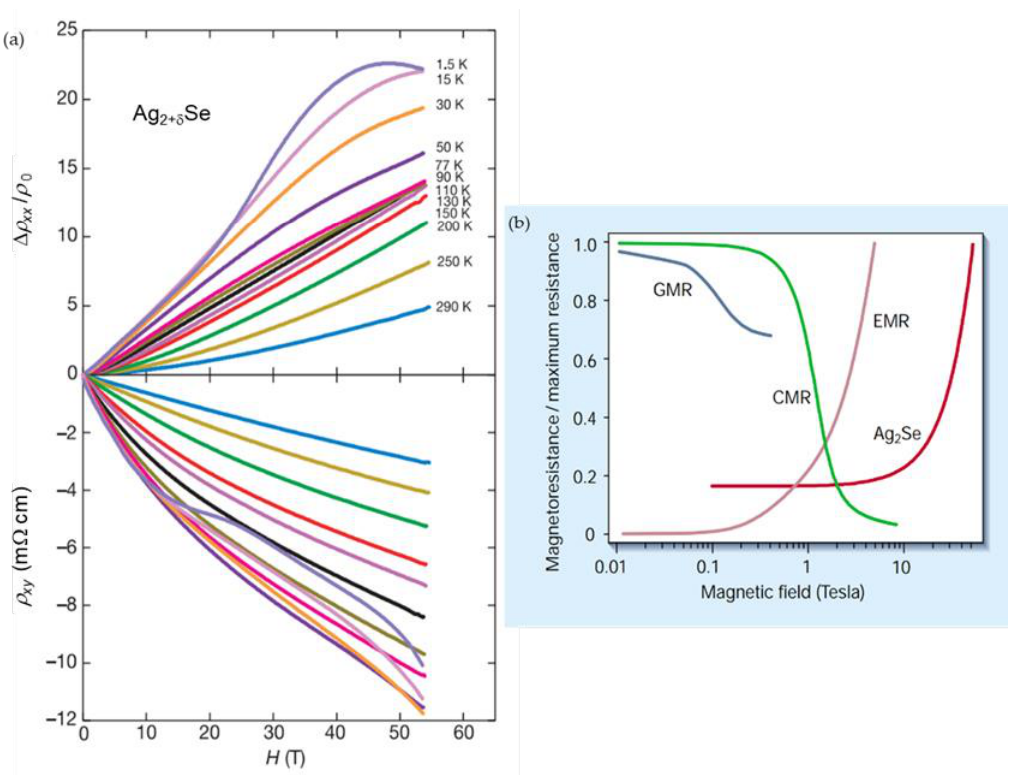
Figure 14. ( a ) Magneto-transport of Ag 2 + δ Se with δ ~ 10 −24 measured in a 55-T pulsed magnetic field. Upper panel: the magnetoresistance vs. magnetic field at different temperatures. Lower panel: field dependence of the Hall resistivity at the same temperatures (color coded). In the low- T , low- H limit, electron density n = 1.1 × 10 18 cm −3 . Reprinted with permission from [104]. Copyright 2002 Springer; and ( b ) performance of magnetic-field sensors. The dependence of magnetoresistance vs. applied magnetic field is shown for typical devices based on giant magnetoresistance (GMR) at a temperature of 295 K, colossal magnetoresistance (CMR) at 220 K and extraordinary magnetoresistance (EMR) at 300 K. Reprinted with permission from [109]. Copyright 2002 Springer.